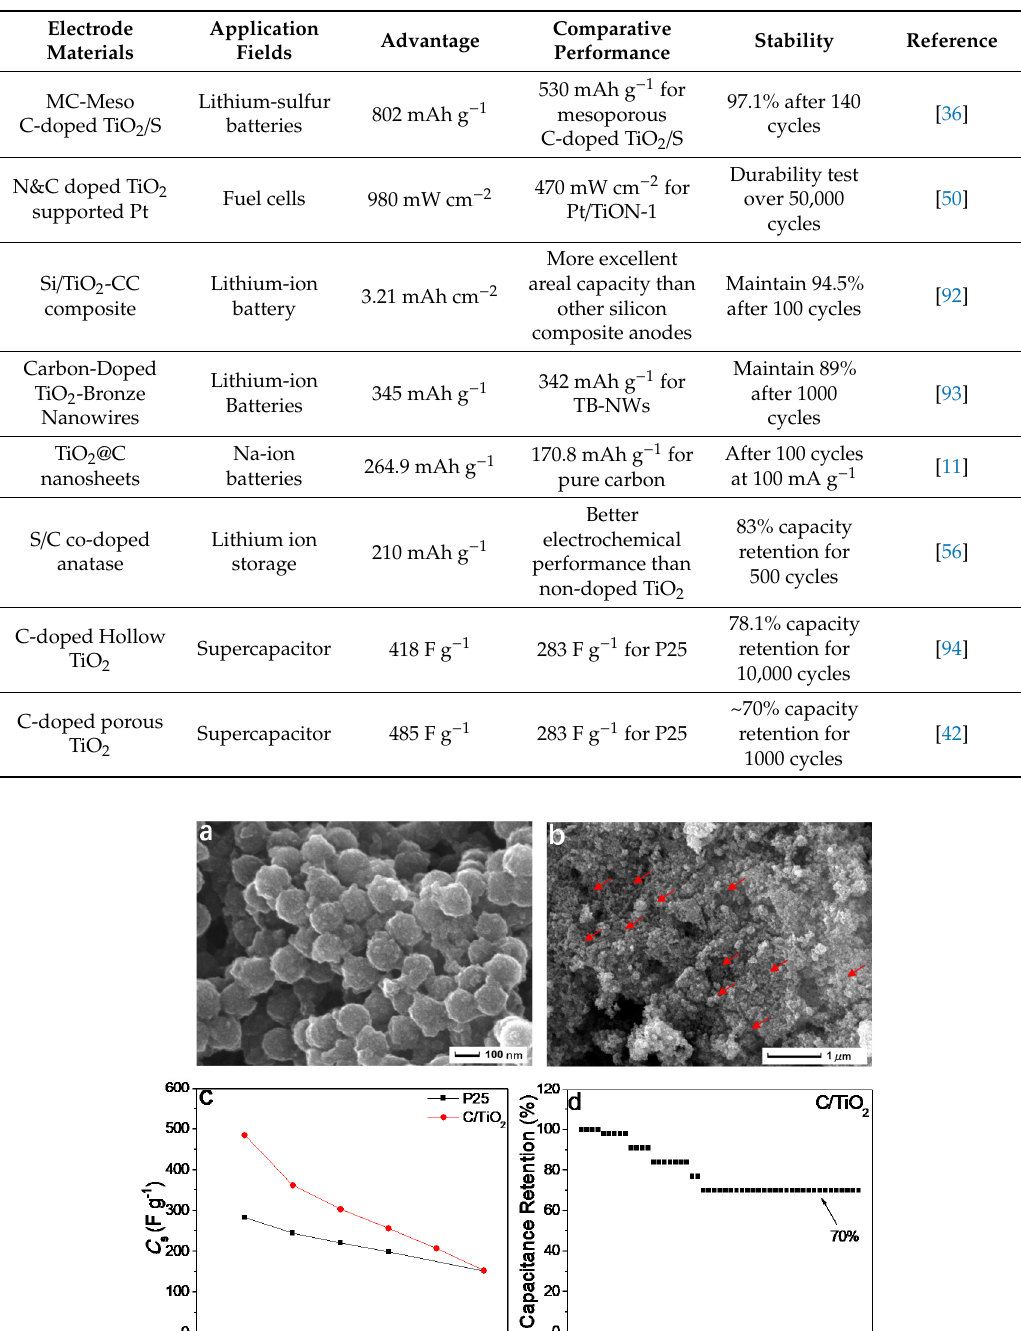
Table 3. The photocatalytic performance of C-doped TiO 2 materials toward the degradation of organic pollutants.